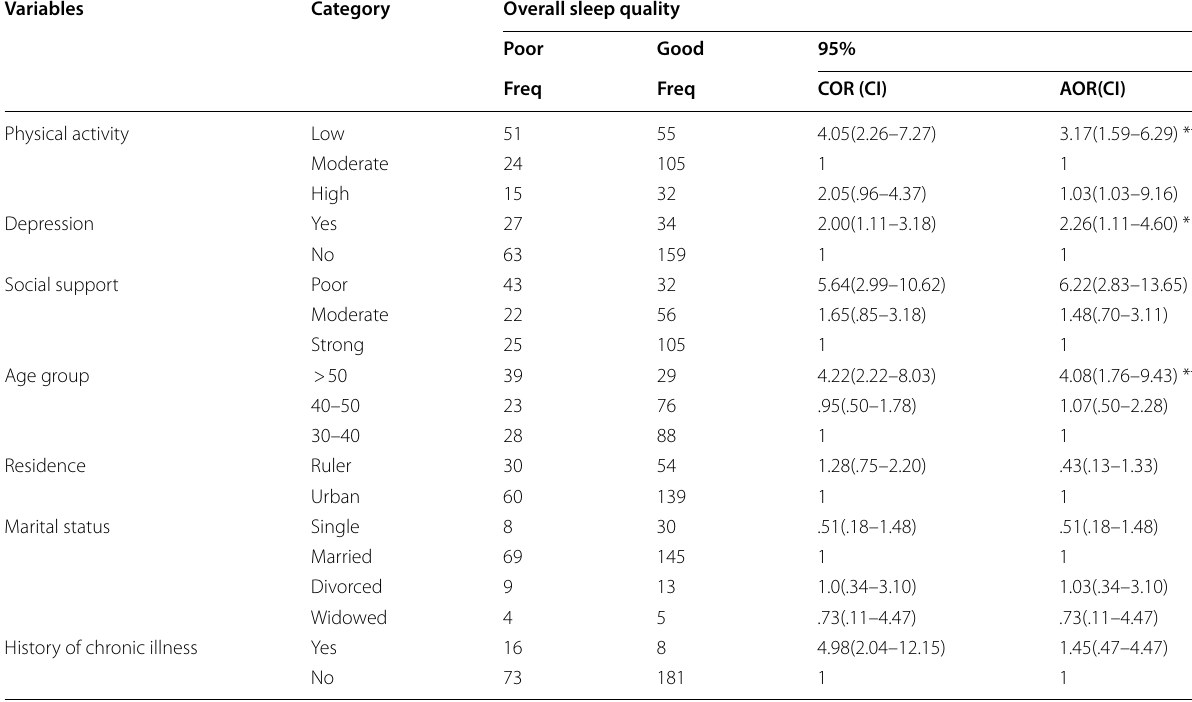
Table 7 Bi-variable and multivariable logistic regression analysis on sleep quality among non-DM individuals in Bahir Dar city,